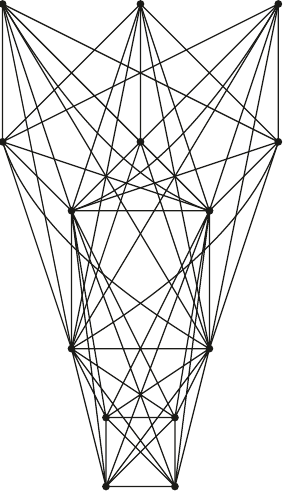
Figure 2: The bidegreed graph H